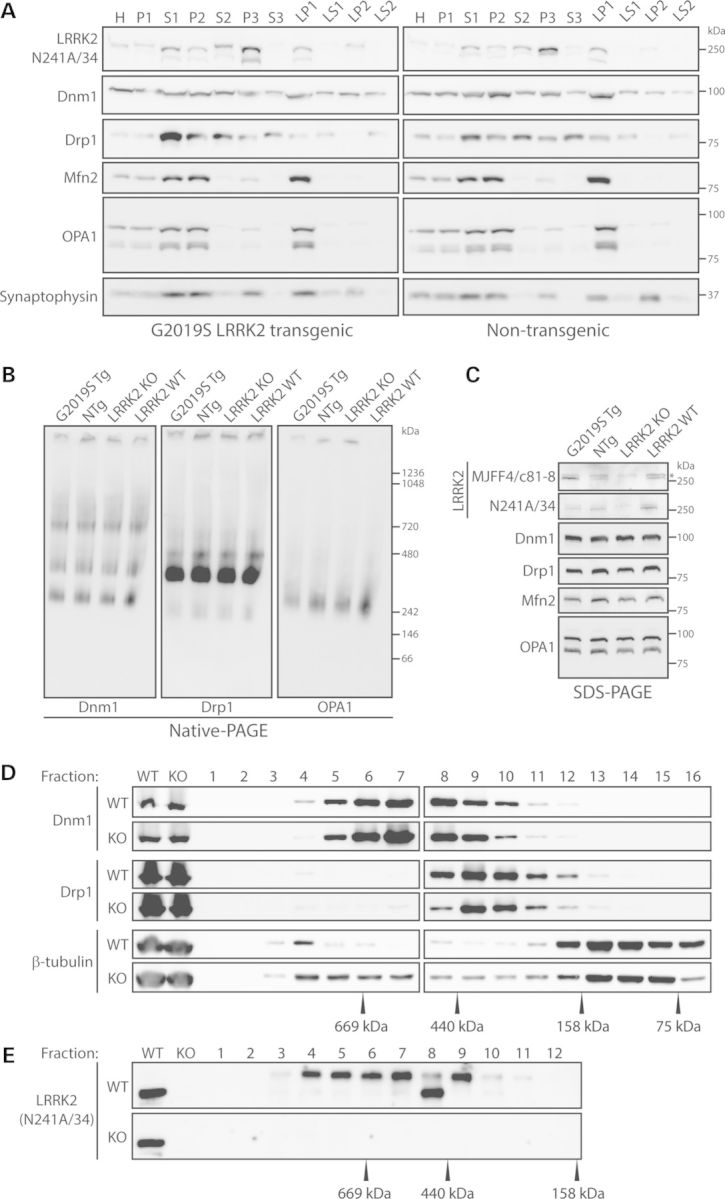
Subcellular distribution and native complexes of dynamin GTPases are not altered by LRRK2 in mouse brain. (A) Subcellular fractionation of cerebral cortex tissue derived from human G2019S LRRK2 transgenic and non-transgenic mice. Dnm1 and Drp1 are broadly distributed across multiple membrane and soluble fractions, whereas Mfn2 and OPA1 are enriched in heavy membrane (P2) and synaptosomal membrane (LP1) fractions. LRRK2 is broadly detected with enrichment in light membrane/microsomal (P3), synaptosomal LP1 and synaptic vesicle-enriched (LP2) membrane fractions. The distribution of the synaptic vesicle-associated protein, synaptophysin 1, demonstrates enrichment of membranes in P2, P3, LP1 and LP2 fractions, whereas Mfn2 and OPA1 indicate enrichment of mitochondria in P2 and LP1 fractions. (B) Native-PAGE and (C) SDS–PAGE analysis of equivalent cerebral cortex extracts derived from human G2019S LRRK2 transgenic (Tg) and non-transgenic (NTg) mice, and LRRK2 KO and WT mice, revealing similar oligomeric protein complexes for Dnm1, Drp1 and OPA1. (C) LRRK2 antibodies confirm the absence of LRRK2 in KO mice (mouse-selective N241A/34 antibody) and human G2019S LRRK2 expression in transgenic mice (human-selective MJFF4/c81-8 antibody; lower band = LRRK2; asterisk indicates non-specific upper band). (D and E) Size-exclusion chromatography on soluble whole brain extracts from WT and LRRK2 KO mice. Sequential fractions (#1–16, 0.5 ml) and total homogenates (WT or KO) were analyzed by western blotting with antibodies to Dnm1, Drp1 and LRRK2 (N241A/34), or β-tubulin as a loading control. The elution profile of Dnm1 and Drp1 is similar in WT and KO brains, whereas the elution profile of individual standards is indicated. LRRK2 antibody (N241A/34) confirms the absence of LRRK2 in KO mice. Blots are representative of duplicate experiments. Molecular mass markers are indicated in kDa.